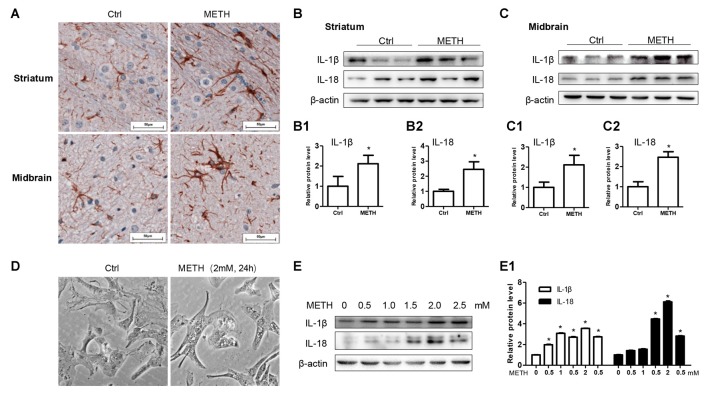
Astrocytes are activated after Methamphetamine (METH) exposure in vitro and in vivo. Male C57BL/6 mice were divided randomly into control and experiment groups (n = 5). Animals were injected intraperitoneally with saline or METH (15 mg/kg/injection, 8 injections, at 12 h intervals). (A) Immunohistochemical staining of GFAP in the striatum and midbrain. Scale bar, 50 μm. Western blot (B,C) and quantitative analyses (B1–C2) were performed to determine IL-1β and IL-18 protein expression in the striatum and midbrain. Primary cultured astrocytes were exposed to 0.5, 1.0, 1.5, 2.0 and 2.5 mM METH for 24 h. (D) Morphological changes were observed. Western blot (E) and quantitative analyses (E1) were performed to determine IL-1β and IL-18 protein expression. β-actin was used as a loading control. Fold induction relative to vehicle-treated group is shown. *p < 0.05 vs. vehicle-treated group. Data were analyzed with Student’s t-test or one-way analyses of variance (ANOVA) followed by LSD post hoc analysis. Data are expressed as mean ± standard deviation (SD).